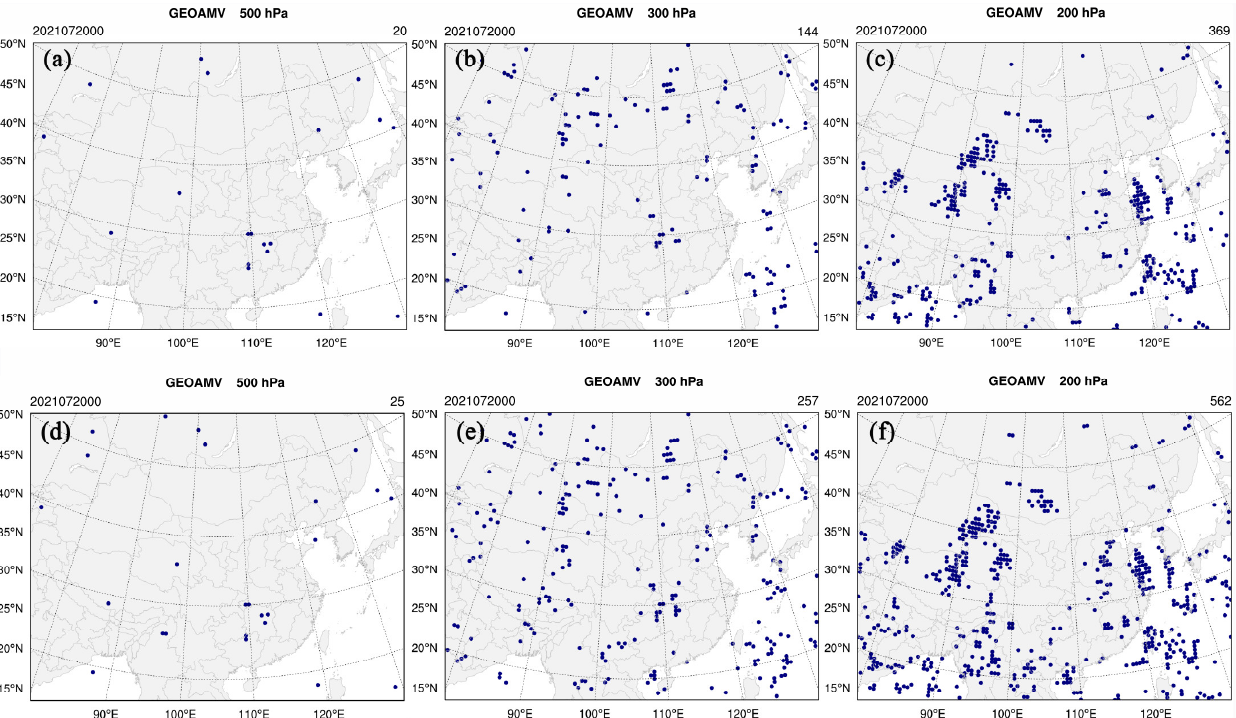
Figure 4. Spatial distribution of FY-4A AMVs used in the data assimilation experiments for the levels of 500 hPa, 300 hPa and 200 hPa at 00 UTC 20 July 2021. ( a – c ) represent the AMVs with QI > 80; ( d – f ) represent the AMVs with QI > 70.